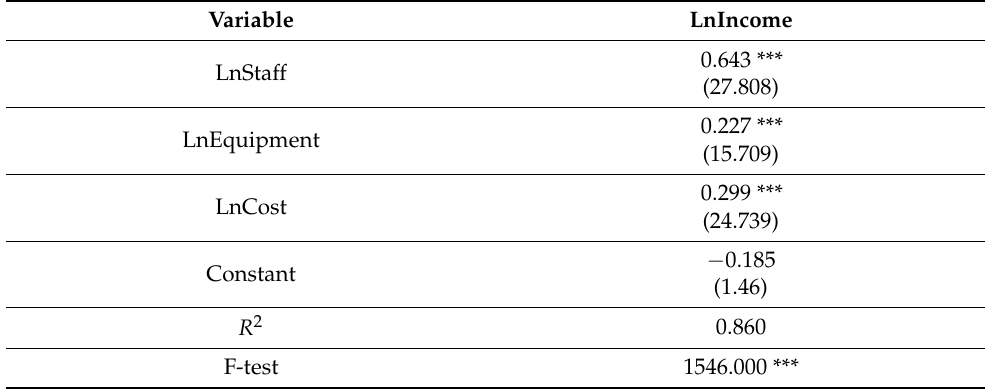
Table 7. Ridge regression